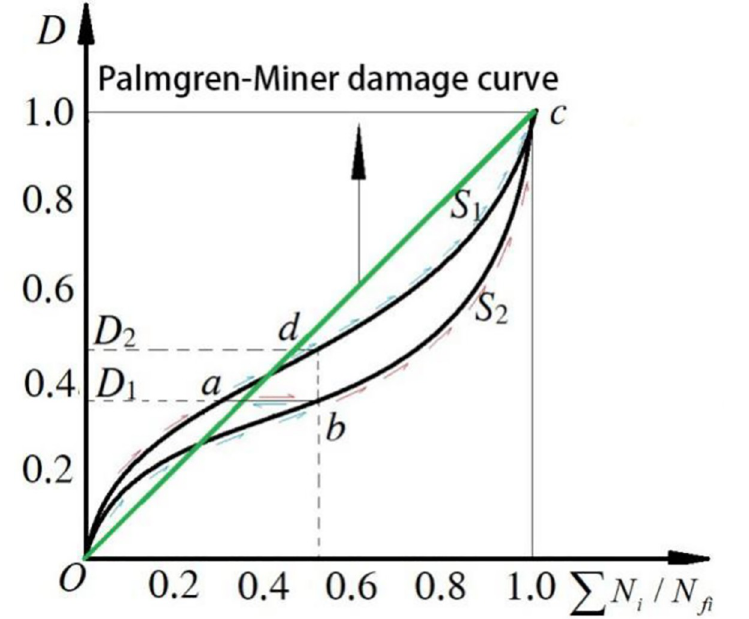
Fig 9. Schematic diagram of fatigue damage development path.